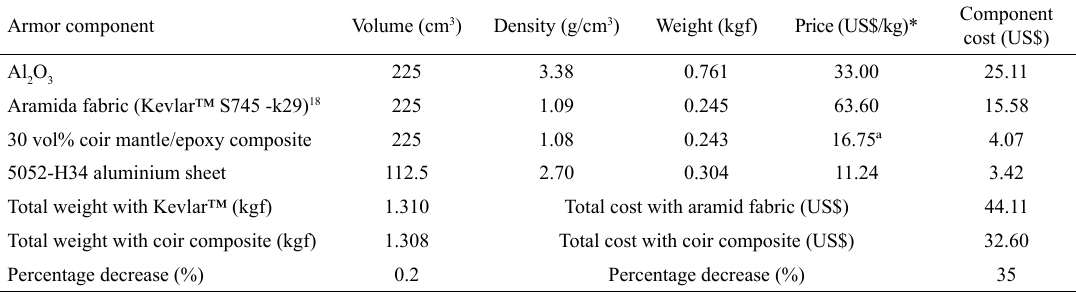
Table 3. Estimative of weight and cost of the different MAS